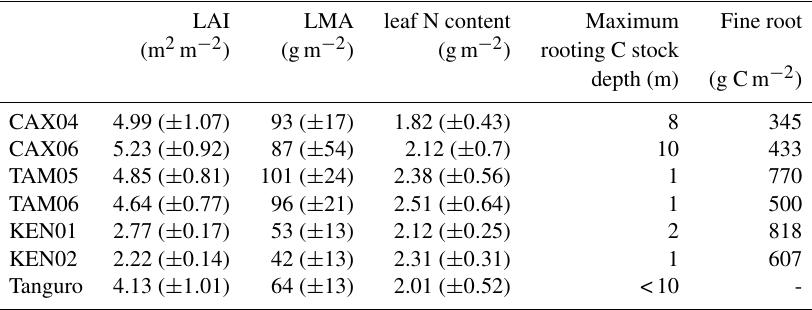
Table 3. Field estimated mean annual leaf area index (LAI), leaf traits, maximum rooting depth and fine root biomass for Amazon permanent sample plots along a MCWD gradient. LAI estimates were derived from monthly hemispherical photographs. LAI, leaf trait and rooting depth estimates were used to constrain SPA model runs. Estimate standard errors are presented in brackets. Fine root C stock estimates were absent for Tanguro plots.